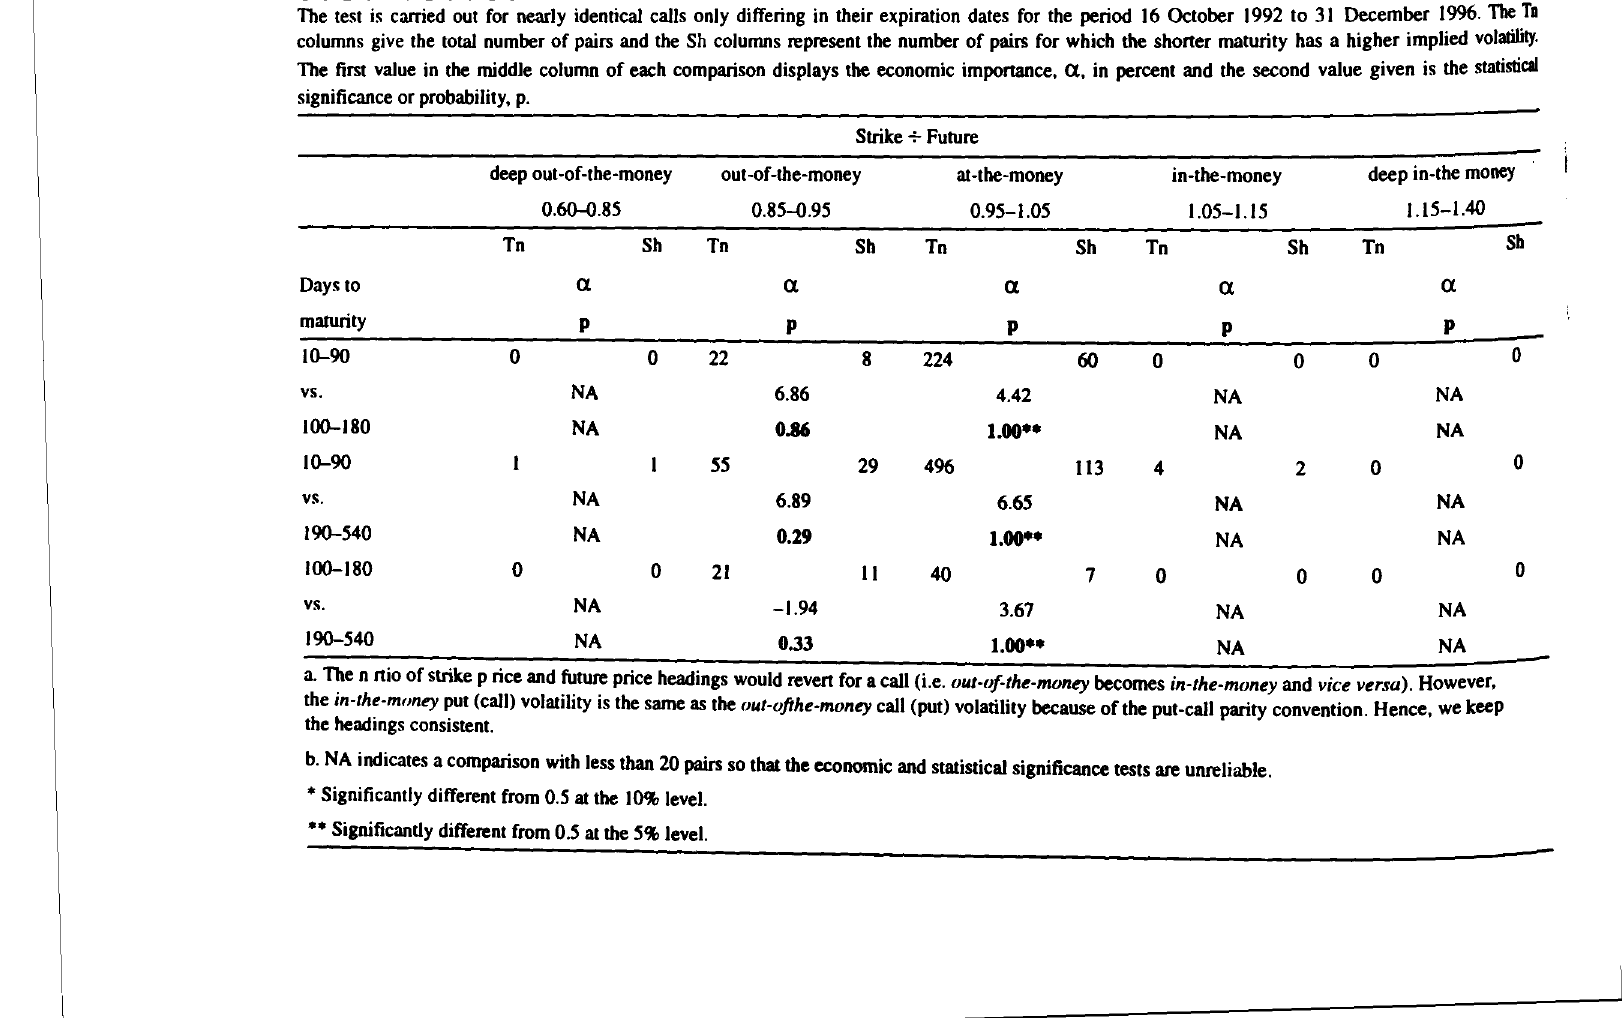
Table A7 Nonparametric time-to-expiration bias test for the put data of the ALSI The lest is carried out for nearly identical calls only differing in their expiration dales for the period 16 October 1992 to 31 December 1996. The Ta columns give the total number of pairs and the Sh columns represent the number of pairs for which the shorter maturity has a higher implied volatility. The first value in the middle column of each comparison displays the economic importance, a, in percent and the second value given is the statistical significance or probability,